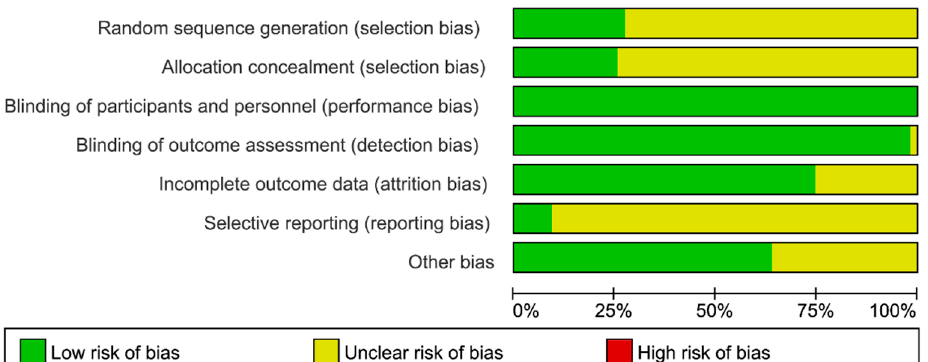
Figure 4. Risk of bias graph: review authors’ judgments about each risk of bias item presented as percentages across all included studies.